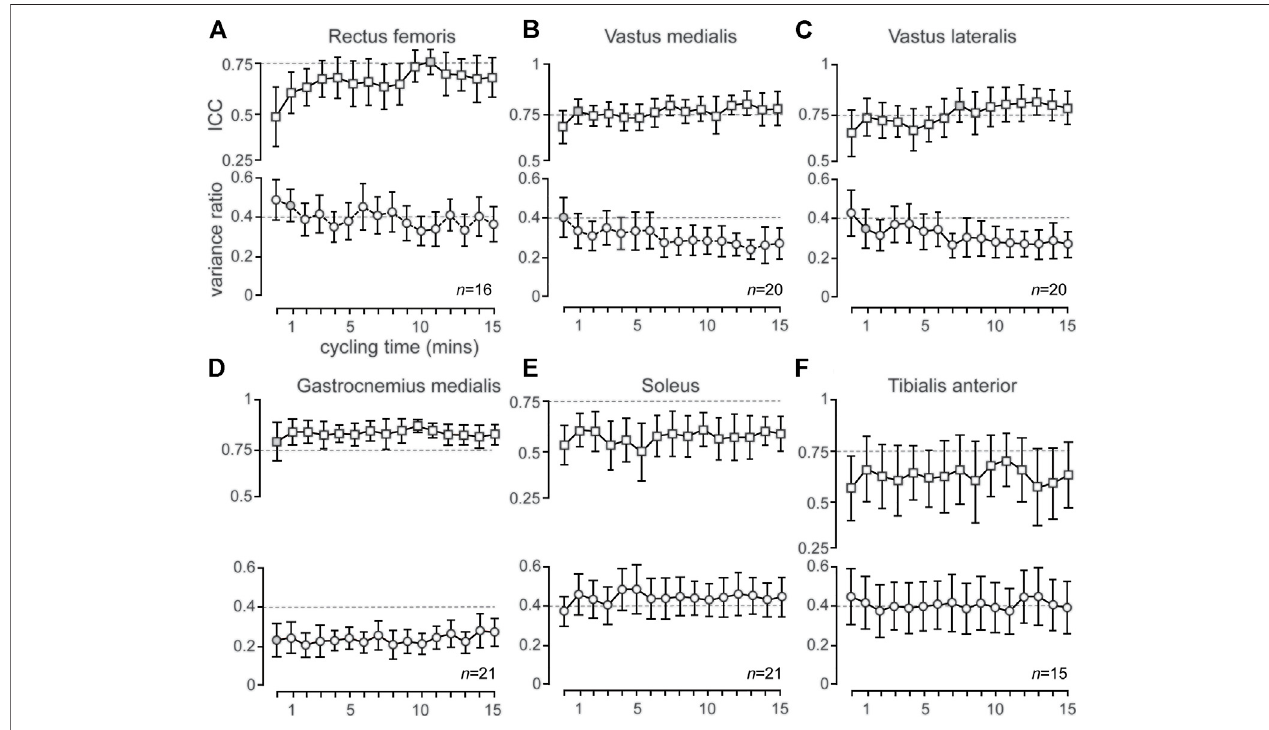
FIGURE 3 | (A – F) : Group mean (±95% CI) ICC (squares) and VR (circles) values are presented for each consecutive time series (ICC) and time (VR). Broken lines represent ICC of 0.75 (i.e., good reliability) and VR of 0.40 (i.e., acceptable upper limit of variability), respectively. Gray shading of icons indicates the point at which the mean ICC and VR familiarization criteria were achieved for the respective muscle. n values (i.e., n = 16) represents the number of individual participants that satis fi ed the familiarization criteria (i.e., achieved and maintained an ICC > 0.50 and VR ≤ 0.40) for the respective muscle.